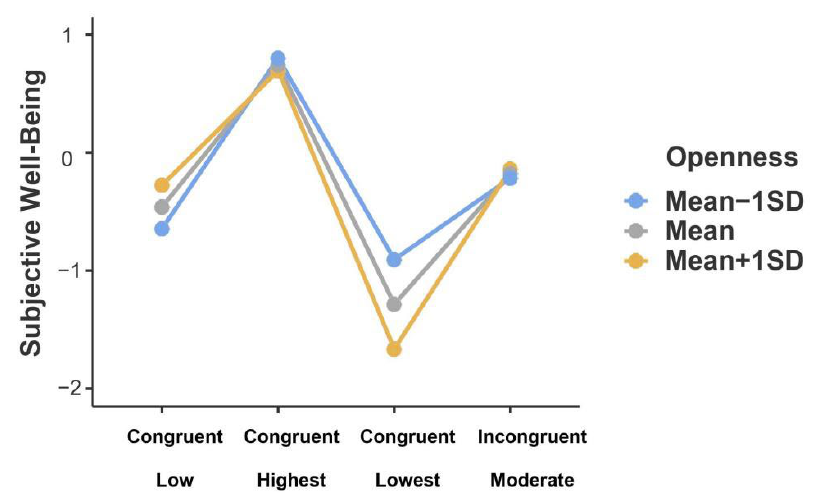
Figure 4. Interaction effect of warmth profiles and openness on subjective well-being in non-left- behind youth. Note . N = 492. Openness was divided into three levels based on mean: Mean − 1 SD, Mean, and Mean + 1 SD.